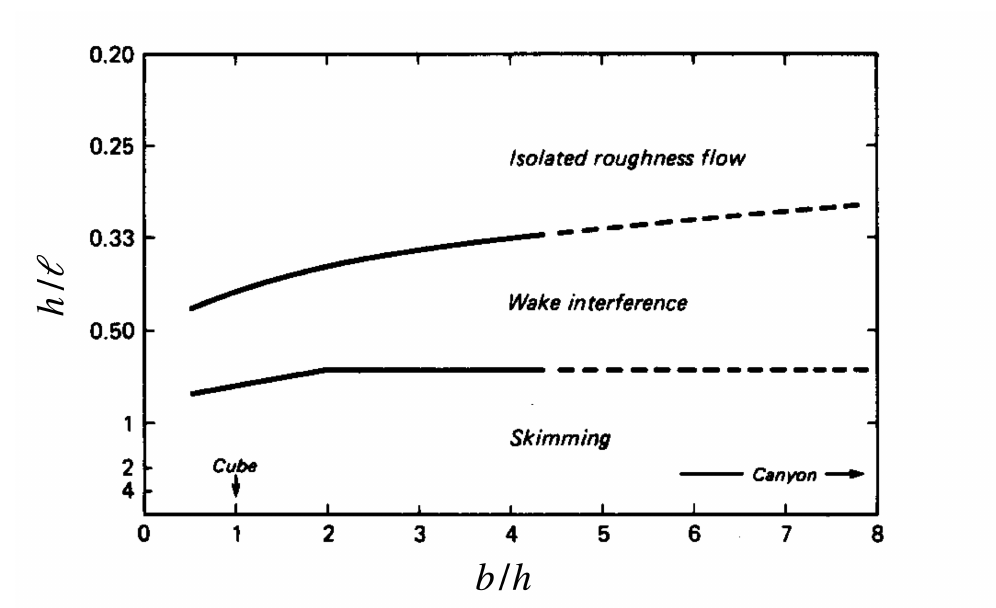
Figure 3. Dependence of the resulting flow regimes on the geometrical parameters shown in Figure 2. Adapted from Ref. [18], with permission of the publisher